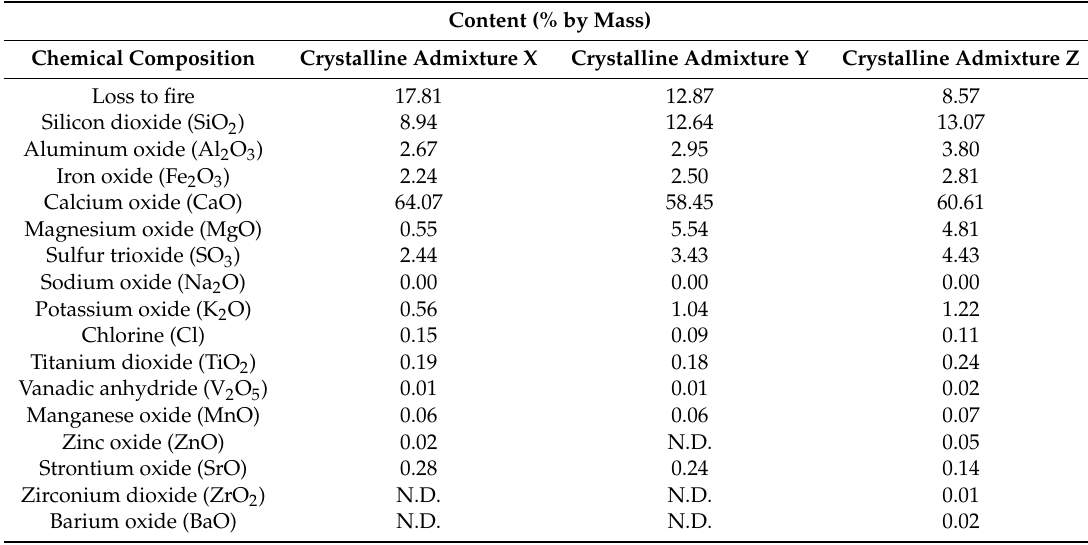
Table 3. Chemical composition of crystalline